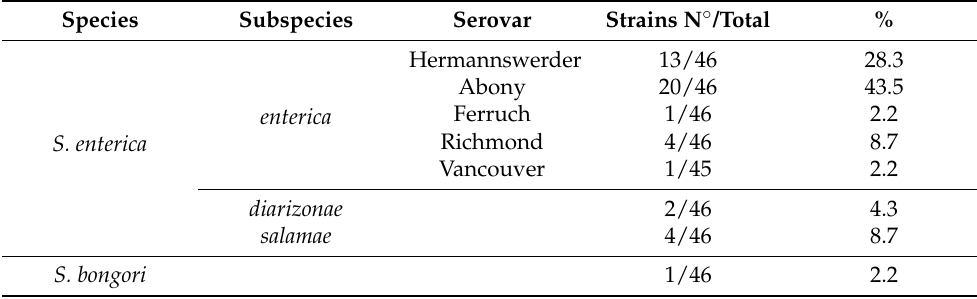
Table 3. Prevalence of serotypes among identified Salmonella